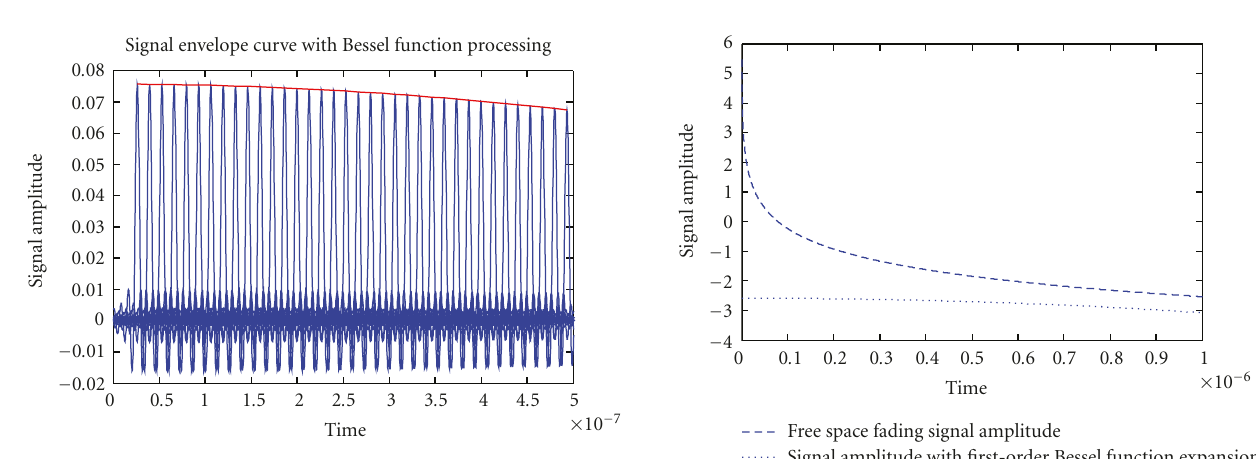
Figure 6: Channel fading signal envelope curve with sinusoid FM signal. Figure 7: amplitude comparison between free space fading signal and the signal with first-order Bessel function expansion.